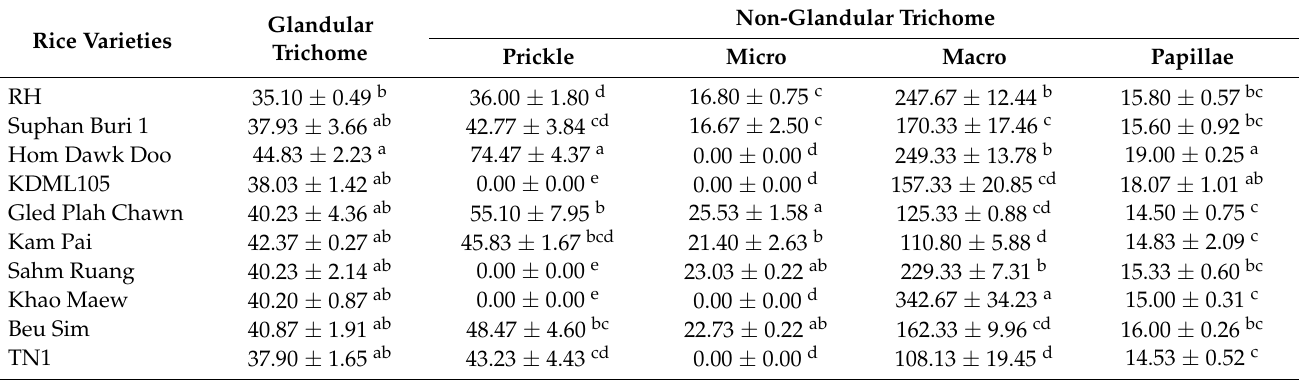
Table 3. Length of trichomes on the leaf surface of 10 rice varieties.